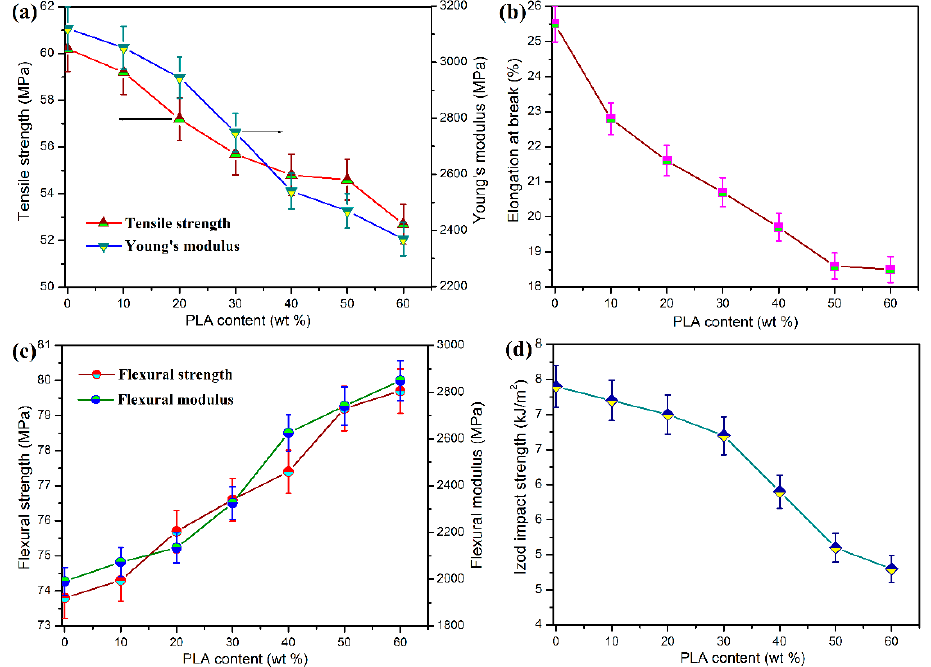
Figure 3. ( a ) Tensile strength and Young’s moduli, ( b ) elongation at break, ( c ) flexural strength and moduli, and ( d ) Izod impact strength of pure POM and its blends with PLA.